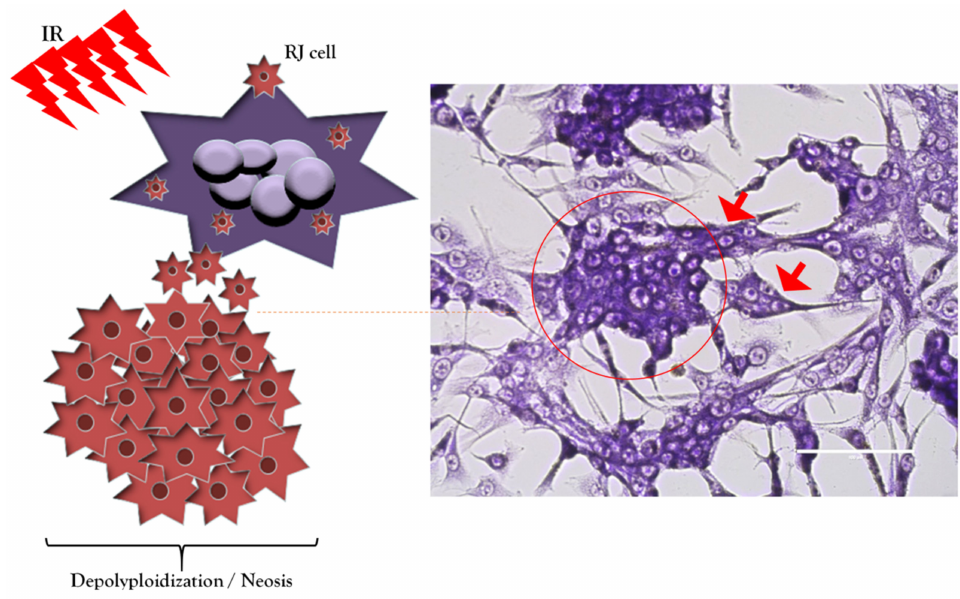
Figure 4. PGCC/MNGC-cell-derived RJ cells in X-ray irradiated GBM U-87